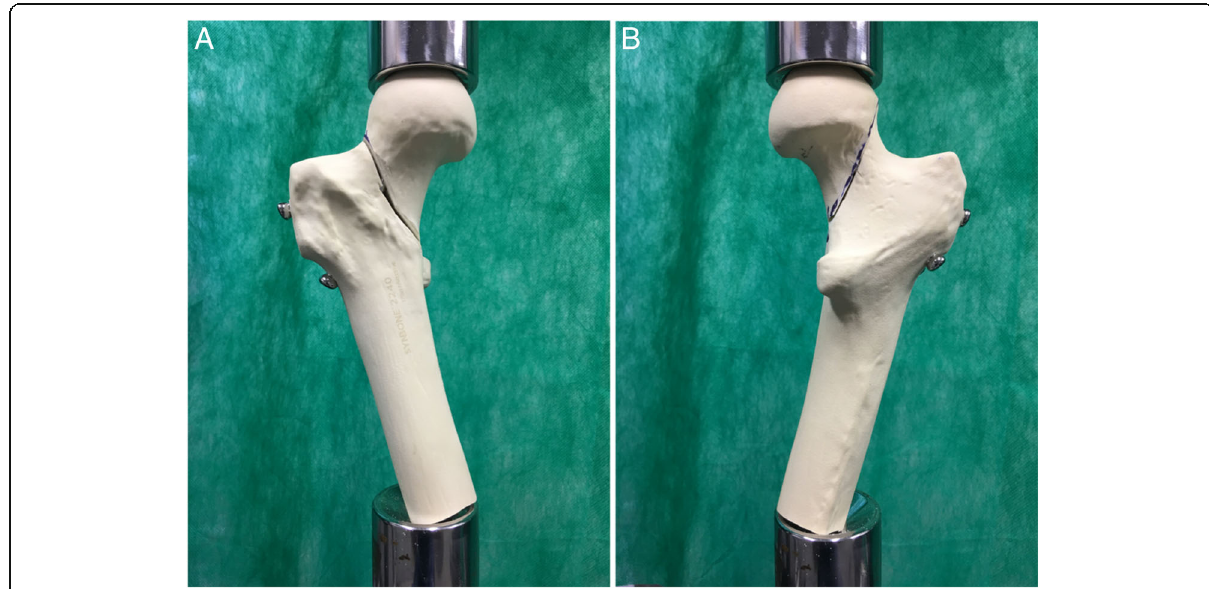
Fig. 2 Group 1 - Assembly with two parallel cannulated screws in the lower portion of the femoral neck + the Pauwels screw in one of the specimens prior to mechanical testing, anterior ( a ) and posterior ( b )